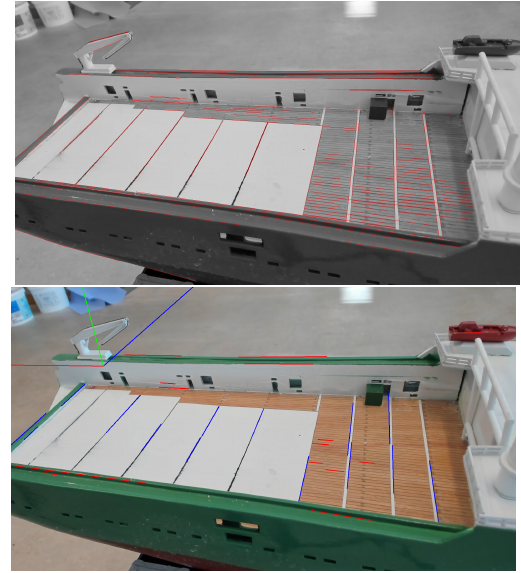
Figure 7: The top image shows the line segments which have been detected while the bottom image shows the vanishing points detection based on these line segments. The blue lines are considered to be parallel in the x direction, and the red lines are parallel in y